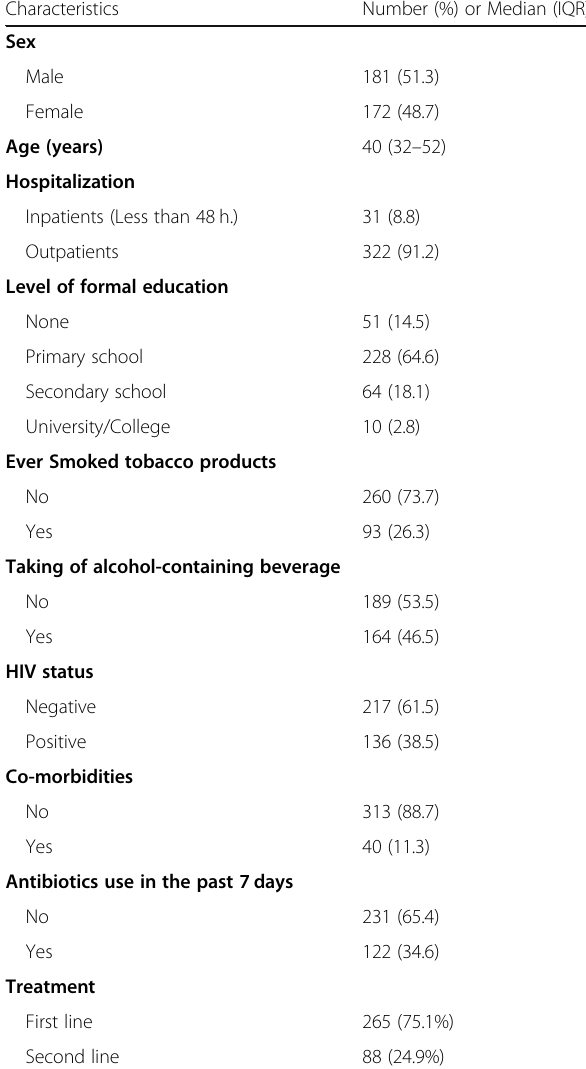
Table 1 Baseline characteristics of 353 adult patients with pneumonia between August and December 2015 in Mwanza, Tanzania